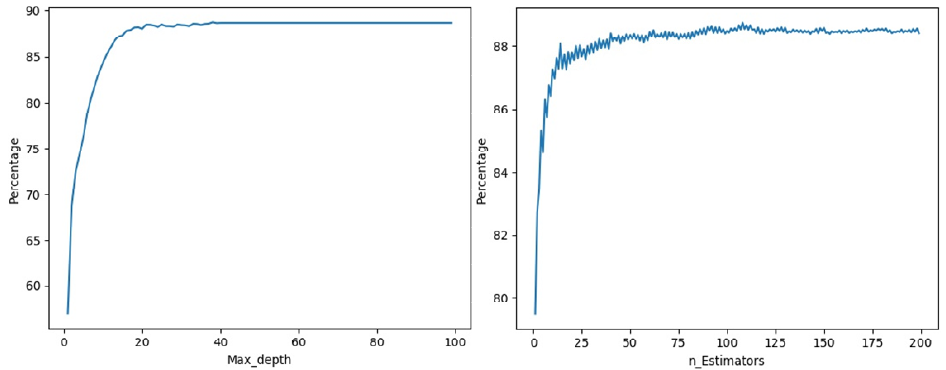
Figure 15. The accuracy of random forest (RF) models with different numbers of trees and max depths applied. Table 3. Temporal accuracy assessment of RF after